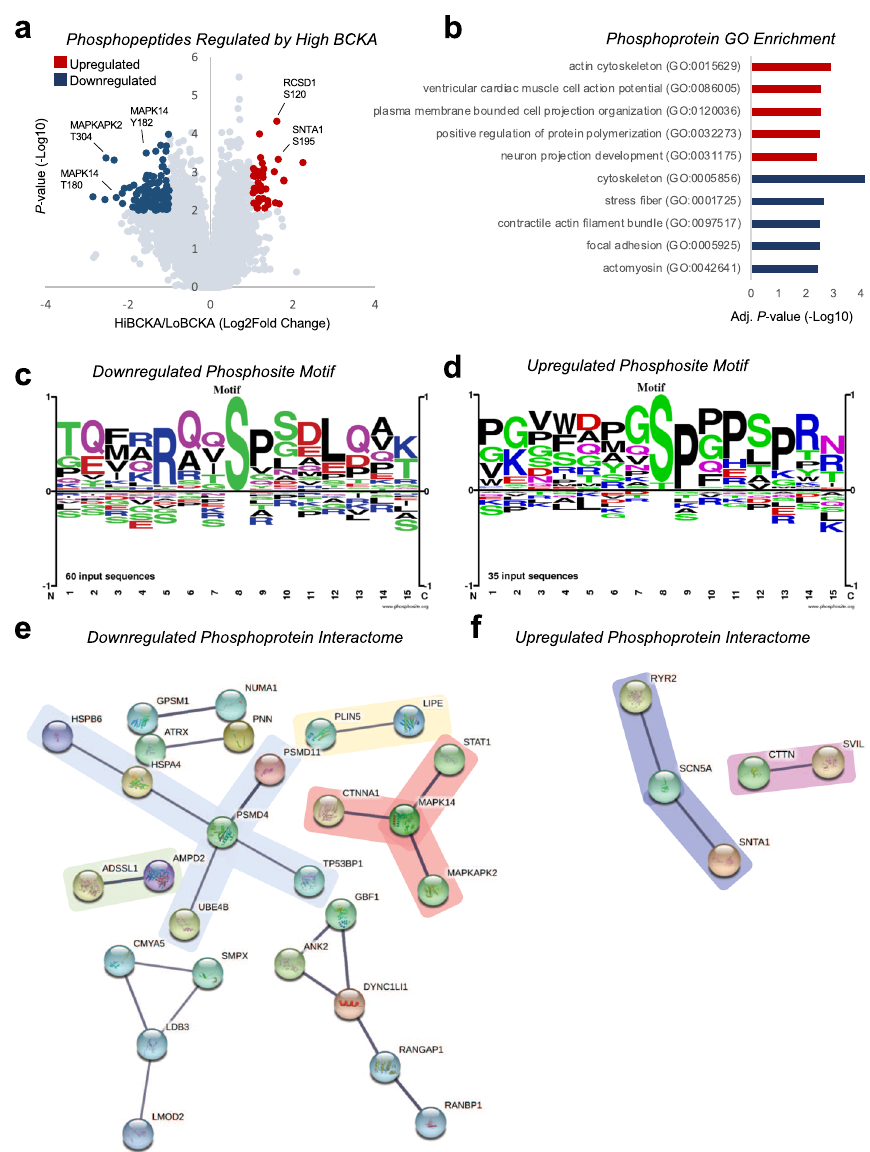
Fig. 5 Effect of BCKA exposure on the cardiac phosphoproteome. a Volcano plot depicting the 9057 phosphopeptides detected using isobaric tandem mass tags (TMT) labeling and one-dimensional liquid chromatography, tandem mass spectrometry (1D-LC-MS/MS) in hearts perfused with levels of BCKA found in lean (LoBCKA; n = 4) or obese (HiBCKA; n = 5) rats. Each data point represents the − Log10 P -value ( y -axis) and Log2 fold change HiBCKA/LoBCKA ( x -axis) for each phosphopeptide following a two-way, paired Student ’ s t-test. A signi fi cance threshold of >2 fold change and P -value <0.01 was used. Signi fi cantly upregulated phosphopeptides are colored red, signi fi cantly downregulated phosphopeptides are colored blue. Phosphopeptides that did not meet the signi fi cance threshold are colored gray. b The top fi ve overrepresented gene ontology (GO) terms for the signi fi cantly upregulated (red) and downregulated (blue) phosphopeptides are shown. Consensus phosphosite motif sequences generated for down and upregulated phosphosites are shown in panels c and d , respectively. e – f Protein-protein interaction networks generated in STRING v11 for signi fi cantly downregulated ( e ) and upregulated ( f ) identi fi ed four distinct nodes with four or more known interactors and four nodes with two interactors (Fig. 5e). These nodes represent a range of distinct biological processes, spanning p38 α MAPK signaling (MAPK14, MAPKAPK2, STAT1, CTTNA1; red), the 26S proteasome (PSMD4, PSMD11, UBE4B, HSPA4, HSPB6, TP53BP1; blue), lipid metabolism (LIPE, PLIN5; yellow), and purine nucleotide cycling (AMPD2, ADSSL1; green). yielded two small nodes (Fig. 5f) representing components of the cardiac action potential (SCN5A, RYR2, SNTA1; purple) and actin reorganization/myosin II assembly (CTTN, SVIL; pink).